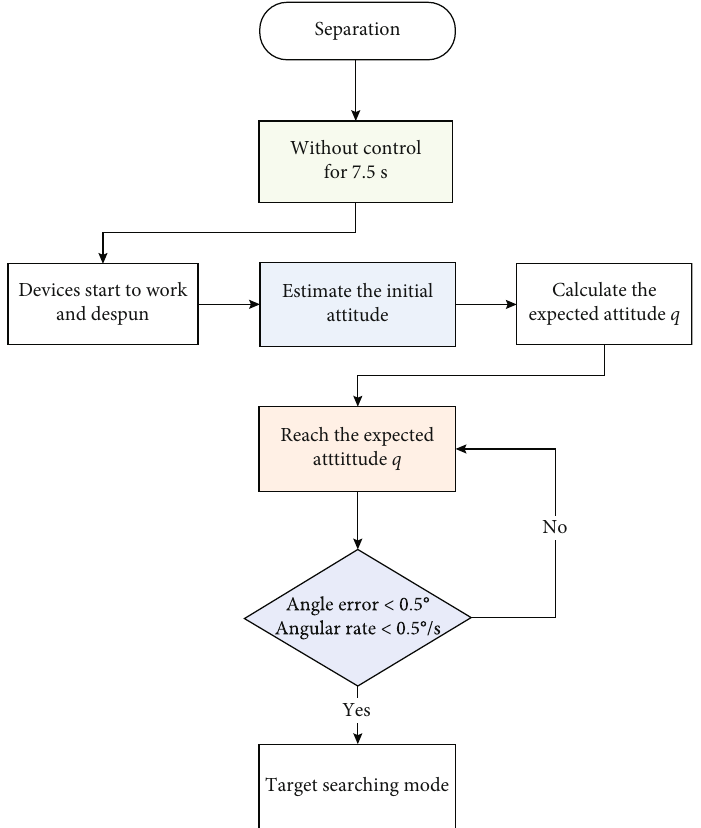
Figure 2: Framework of the initial attitude estimation